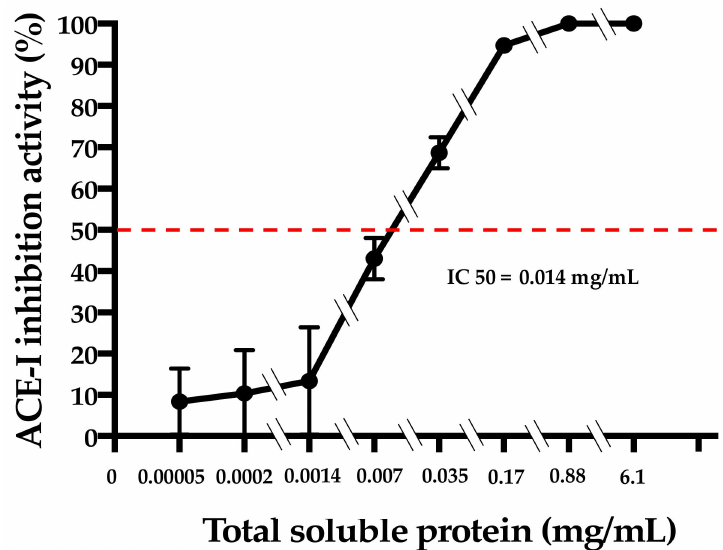
Figure 1. IC50 (half-inhibitory concentration) estimation of the amaranth hydrolysate (optimized hydrolysate parameters: pH 7.01; temperature 52 ◦ C; enzyme concentration 0.04 mU / mg of protein; reaction time 6.16 h). ACE-1: angiotensin-1-converting